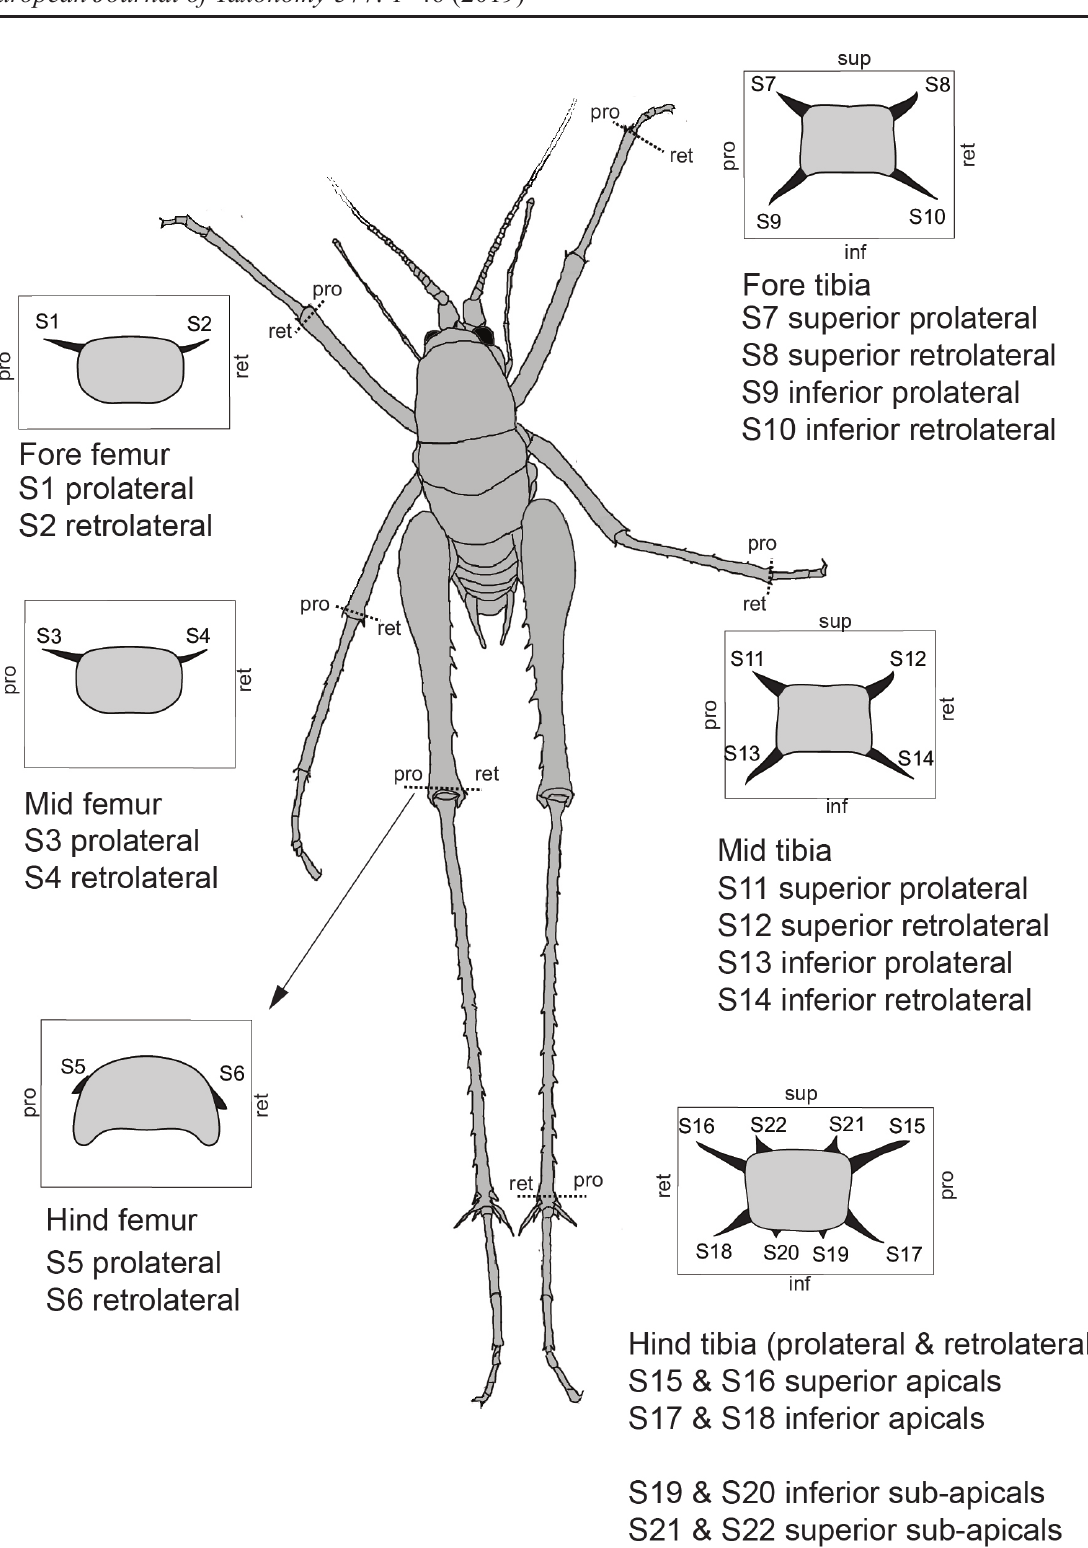
Fig. 1. Apical spine numbering, terminology and position in Rhaphidophoridae Walker, 1869, after Fitness et al. (2015). Dorsal view, showing cross-sectional relationship of each potential spine on femora and tibiae. Positions are indicated as prolateral (anterior facing), retrolateral (posterior facing), inferior (ventral facing) and superior (dorsal